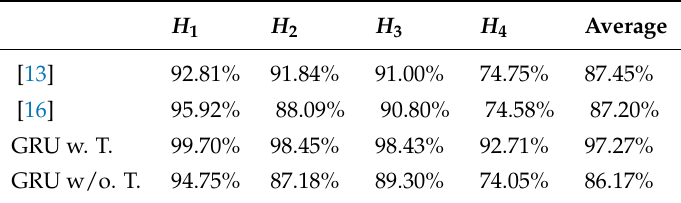
Table 6. Comparisons of the hit rates of various algorithms on the testing data set for finger gesture recognition. The w. T. and w/o. T. denote the training operations with and without inclusion of transitions, respectively. H 1 H 2 H 3 H 4 Average [13] 92.81% 91.84% 91.00% 74.75% 87.45% [16] 95.92% 88.09% 90.80% 74.58% 87.20% GRU w. T. 99.70% 98.45% 98.43% 92.71% 97.27% GRU w/o. T. 94.75% 87.18% 89.30% 74.05%